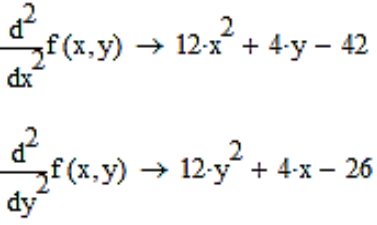
Figure 28. Second partial derivatives of the Himmelblau’s function, calculated in Mathcad.